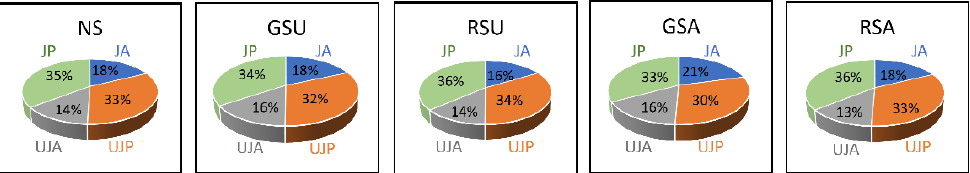
Figure 9. A numerical division of the users’ decisions throughout the game into four categories: (1) justified purchasing (JP); (2) unjustified purchasing (UJP); (3) justified avoidance (JA); and (4) unjustified avoidance (UJA).